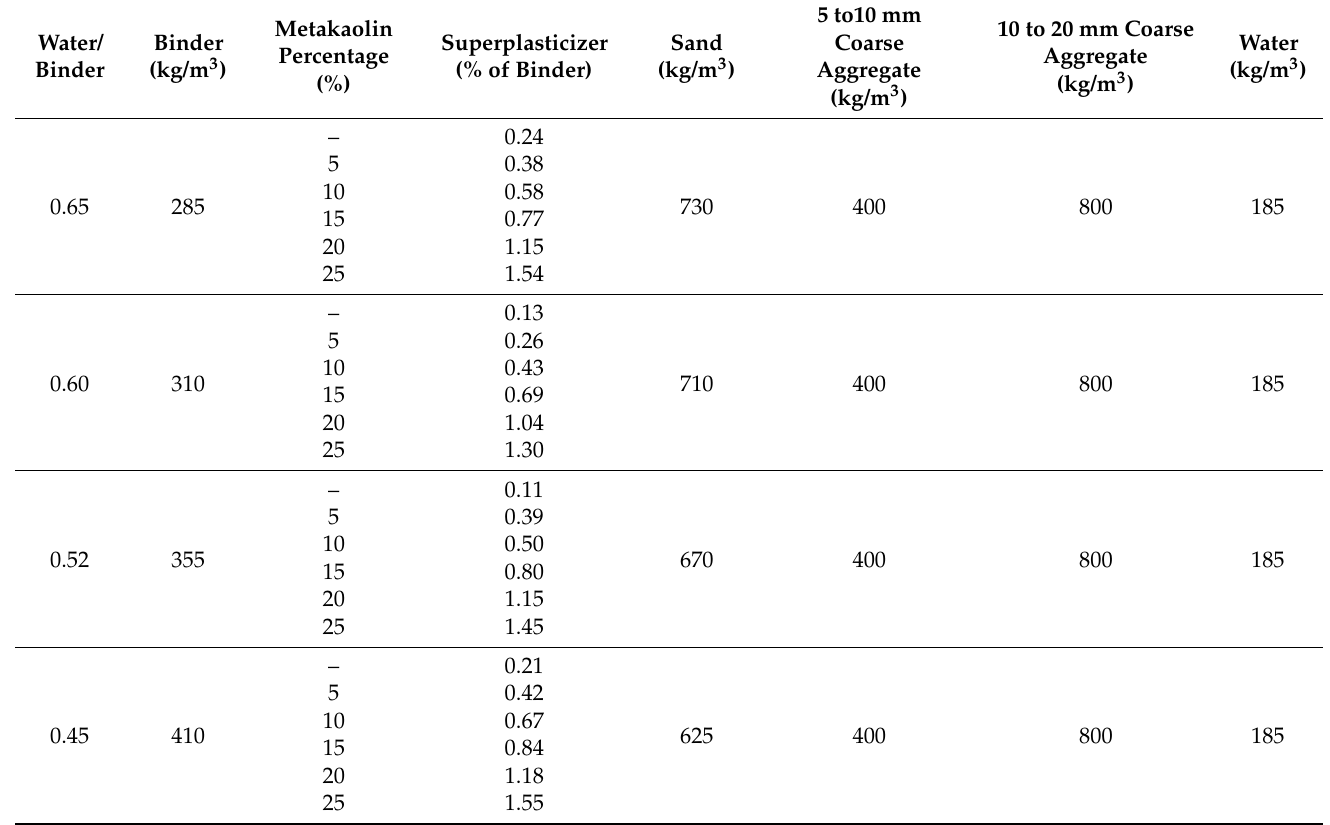
Table 1. Mixtures of specimens. Adapted with permission from ref. [26]. Copyright 2018